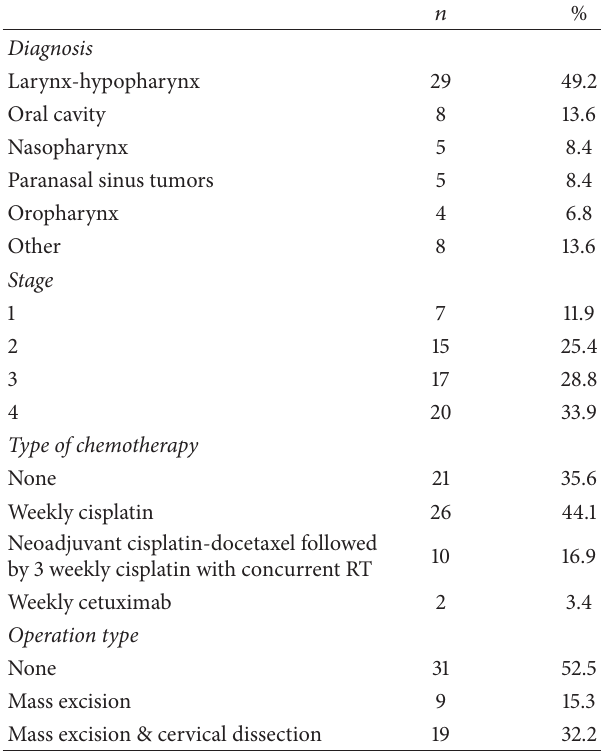
Table 1: Baseline characteristics of